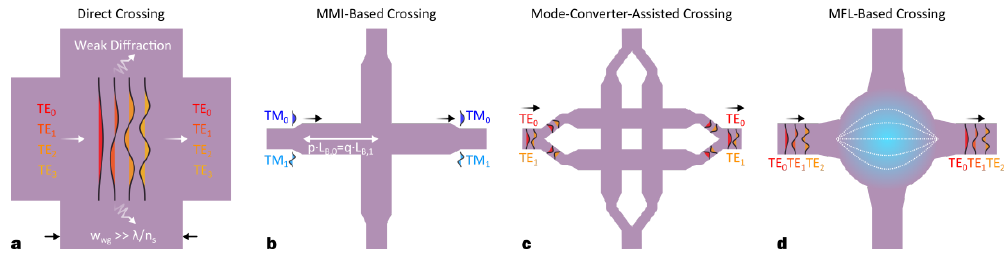
Figure 15. The schematics for different silicon multi-mode crossings: ( a ) direct crossing [194], ( b ) MMI-based crossing [197,198], ( c ) mode converter-assisted crossing [199,200], ( d ) Maxwell’s fisheye lens (MFL)-based crossing [201,202].